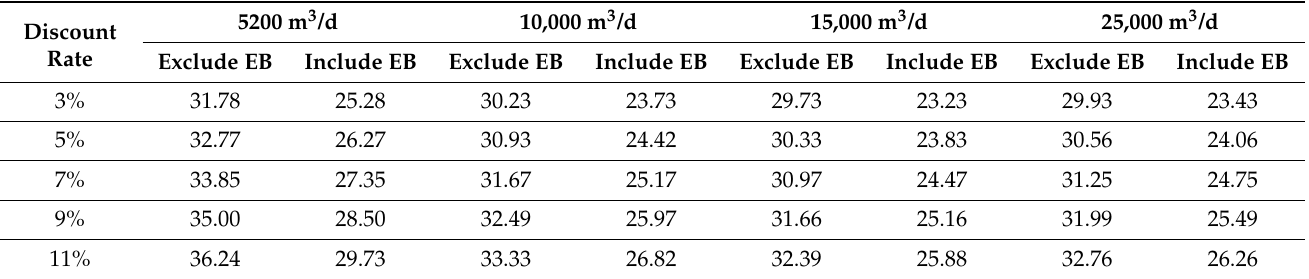
Table 4. Minimum selling price of reclaimed water (THB) for water reclamation projects for industrial water supply when including and excluding environmental benefits